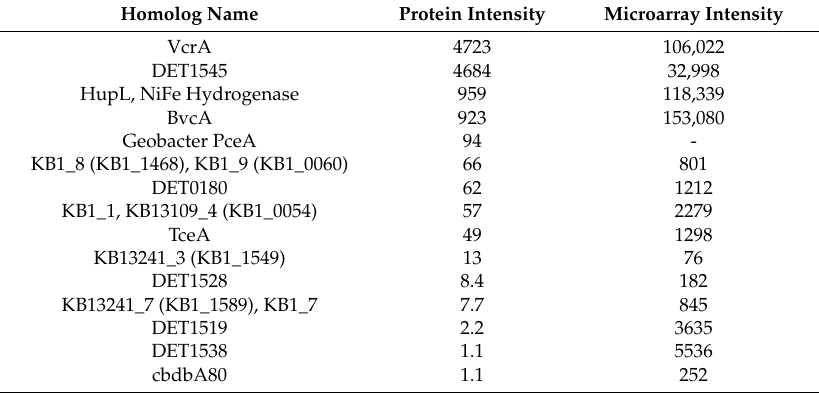
Table 1. Organohalide respiration biomarkers and selected housekeeping gene biomarkers detected by shotgun proteomics in a KB-1 TM metaproteome sample and corresponding pangenome microarray probe intensities. Protein intensity proxy is NSAF = Normalized Spectral Abundance Factor (times 10 5 ) for all detected protein homologs. For pangenome microarray data the corresponding probe with the highest intensity is shown. With the exception of the hydrogenase, HupL, all listed biomarkers are reductive dehalogenases. Geobacter ’s PceA gene was not on the pangenome